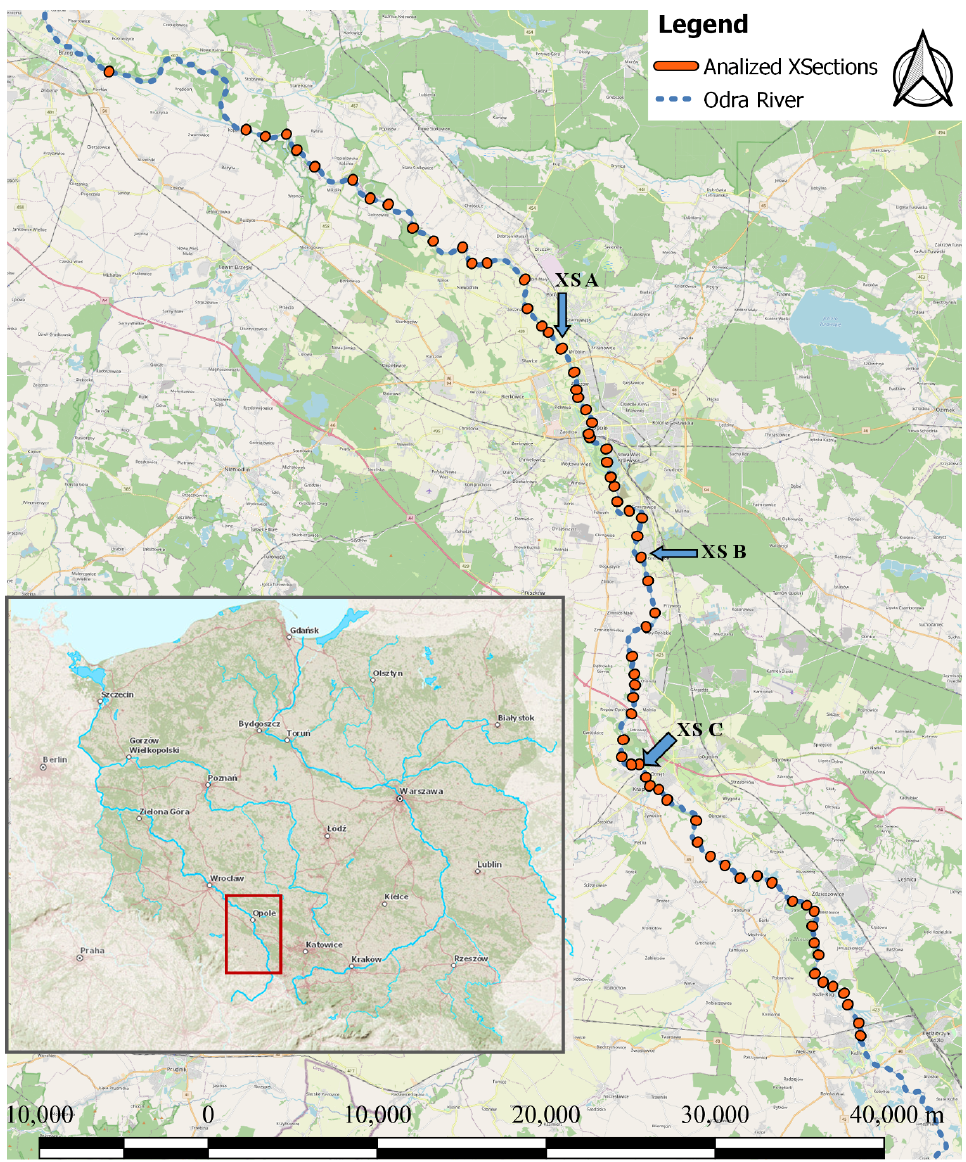
Figure 3. Geographical location of the analyzed cross-sections. Source of background maps: Open Street Map and the ISOK